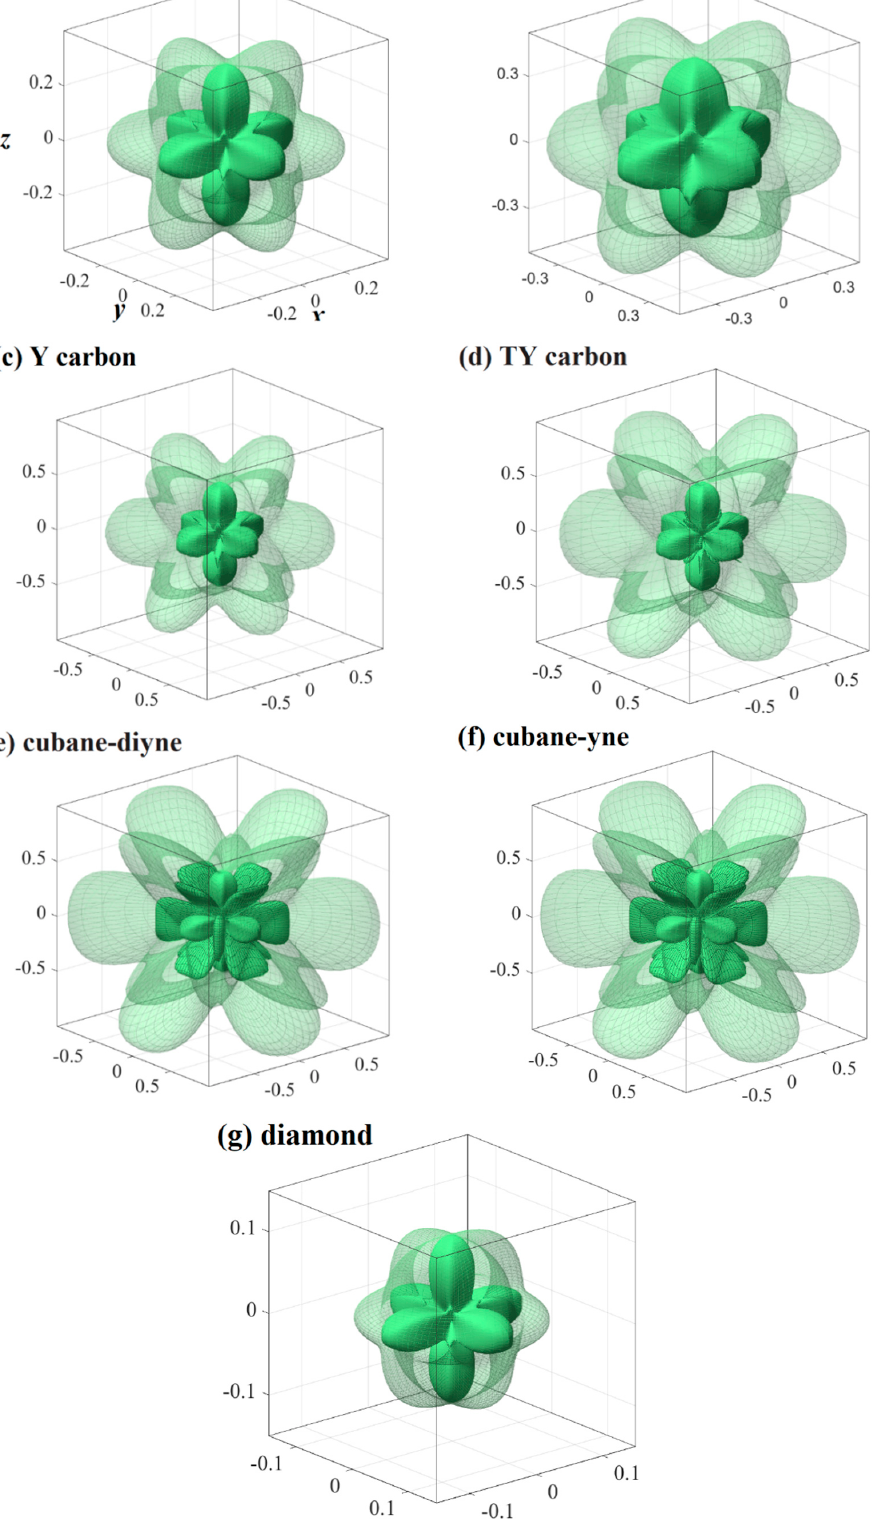
Figure 5. Three-dimensional contour plots of the Poisson’s ratio for supercubane ( a ), T carbon ( b ), Y carbon ( c ), TY carbon ( d ), cubane-diyne ( e ), cubane-diyne ( f ), and diamond ( g ).